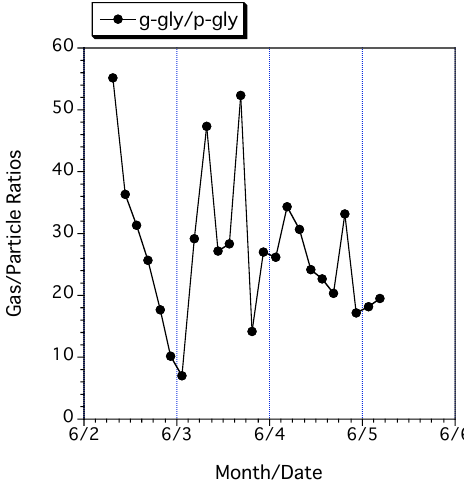
Fig. 10. Time-resolved variation of gas/particle partitioning of gly- oxal in the atmosphere of Mt. Tai. Particulate glyoxal data are from Kawamura et al.